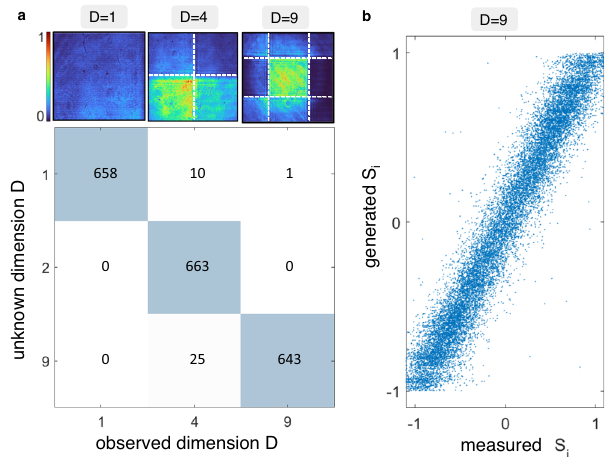
Fig. 6 | Measurement of a beam of unknown polarization number. a Confusion matrix over N test =2000 beams with three possible values for D . Insets are repre- sentative projective images in the three cases. D is determined with 98% accuracy. b Single-shot measured versus generated Stokes parameters for beams of nine parts, whose dimension has been automatically identi fi